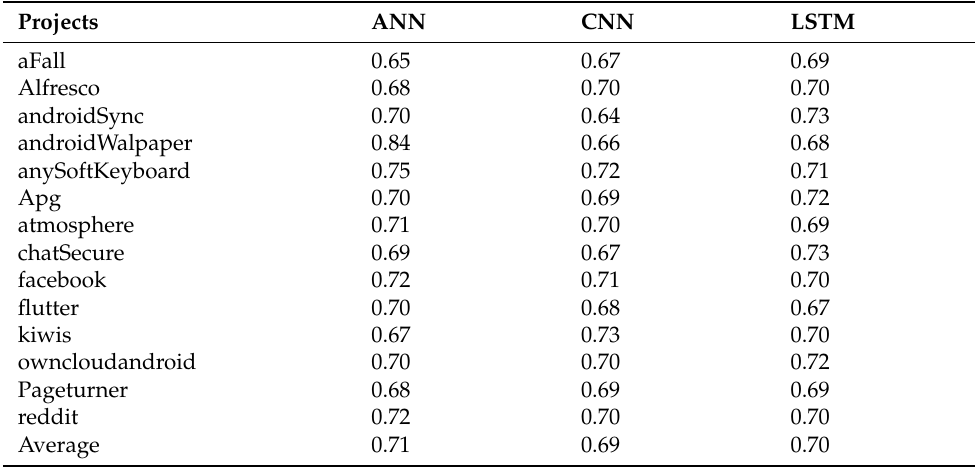
Table 5. Cross-project analysis results